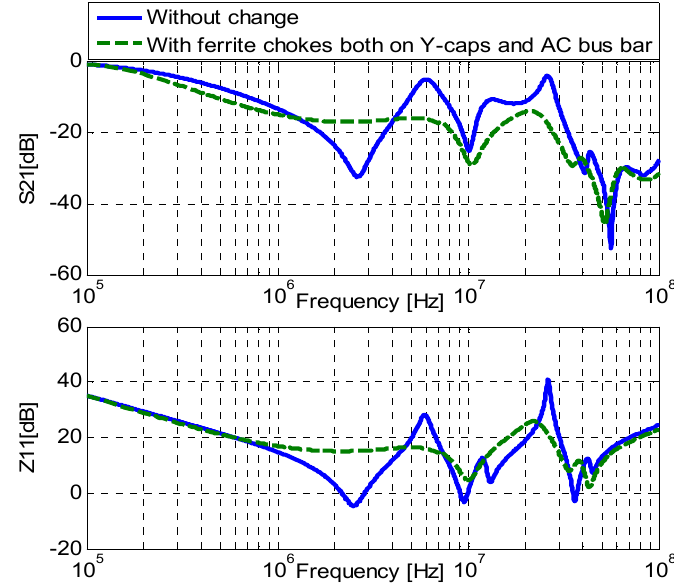
Figure 19. Change in Z11 and S21 after adding CM ferrite chokes through the Y ‐ caps and the AC bus bar.